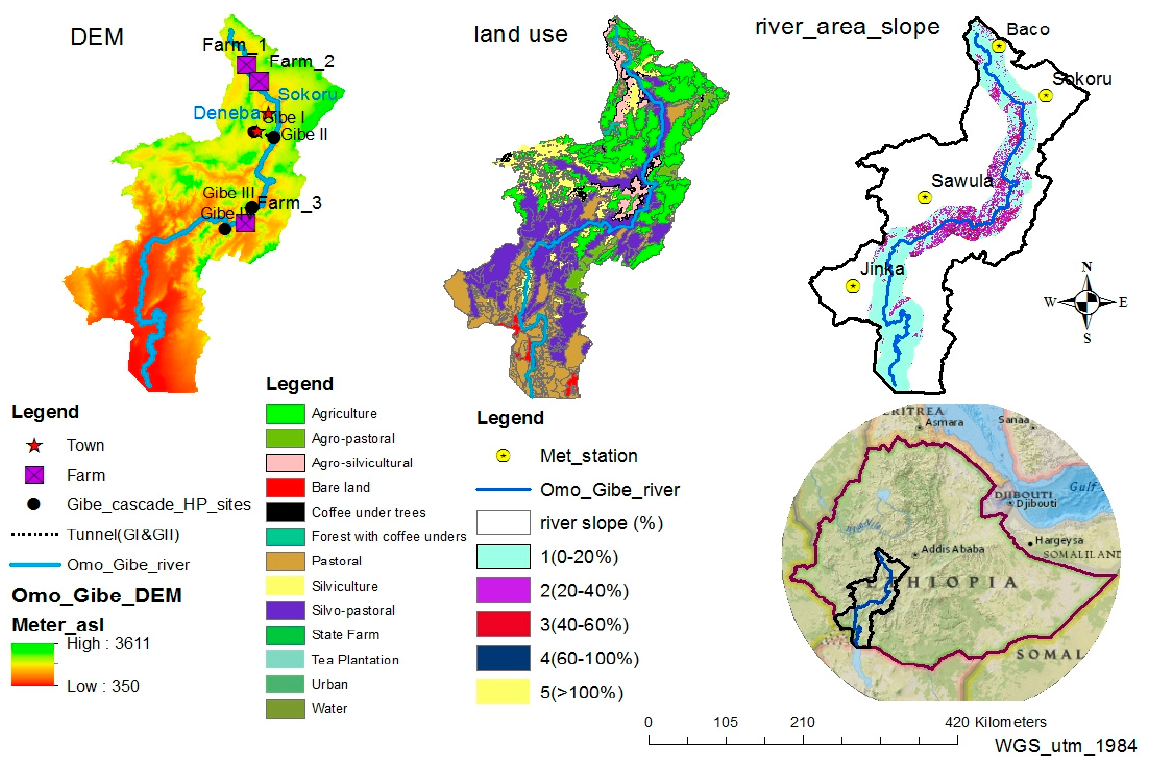
Figure 3. Pictures of the Omo Gibe river basin showing the elevation, towns, Gibe cascade hydro- power plants, land use distribution, the slope along the river length, and agricultural farms (data sources FAO, DAFNE database, 2019).